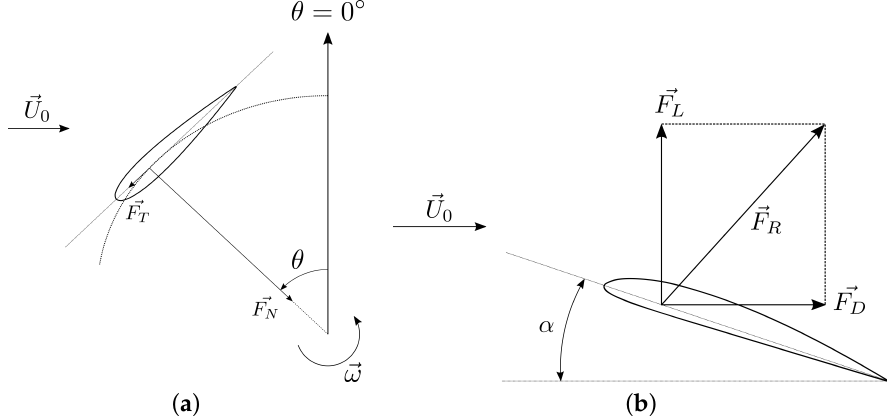
Figure 5. ( a ) Components of the forces applied to the blade of a vertical axis turbine, subjected to a flow with free stream velocity U 0 . ( b ) Components of the forces applied to an airfoil, where α is the angle of